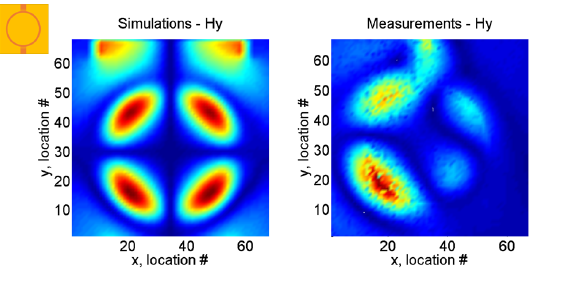
Figure 9: | H y | magnitude of the magnetic field for simula- tions (CST (cid:114) , left) and measurements (right) in the vicinity of the empty ring resonator at f = 2 . 66 GHz.